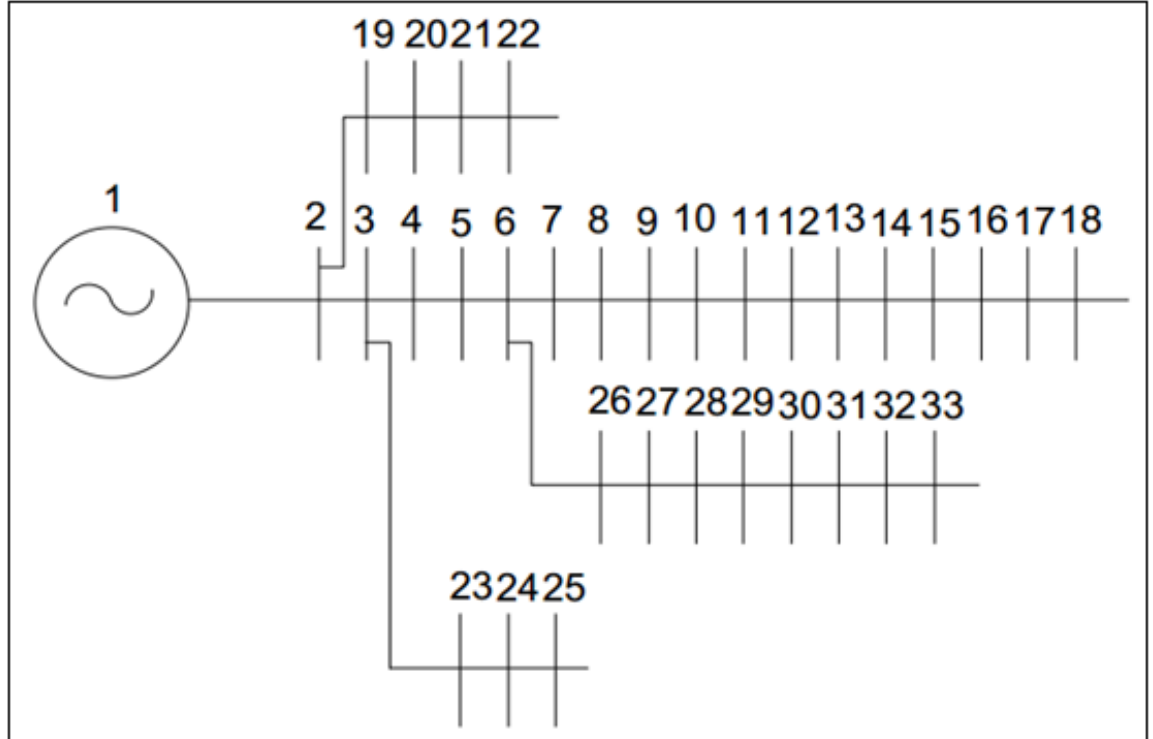
Figure 4. The 33-bus distribution network [33].